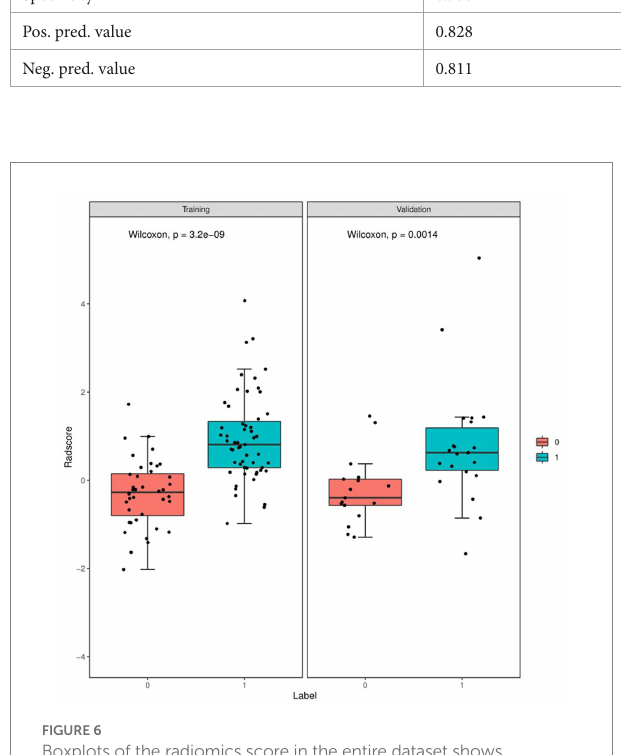
FIGURE 6 Boxplots of the radiomics score in the entire dataset shows difference between luminal and non-luminal molecular subtypes based on DCE-MRI images. The luminal group is red, the non- luminal group is